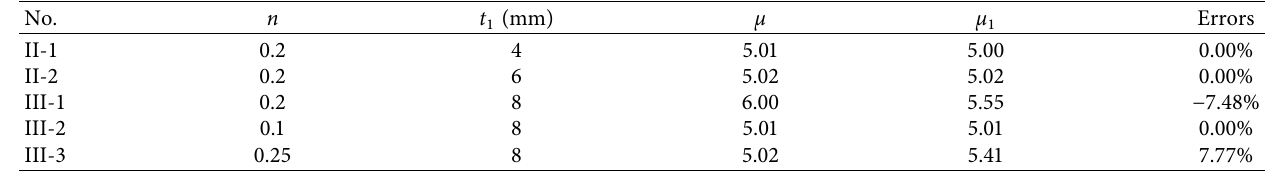
Figure 17: Cumulative hysteretic energy curves. (a) Impacts of energy-dissipating plates. (b) Impacts of the thickness of energy-dissipating plates. (c) Impacts of axial compression ratio. Table 5: Design parameters and displacement ductility